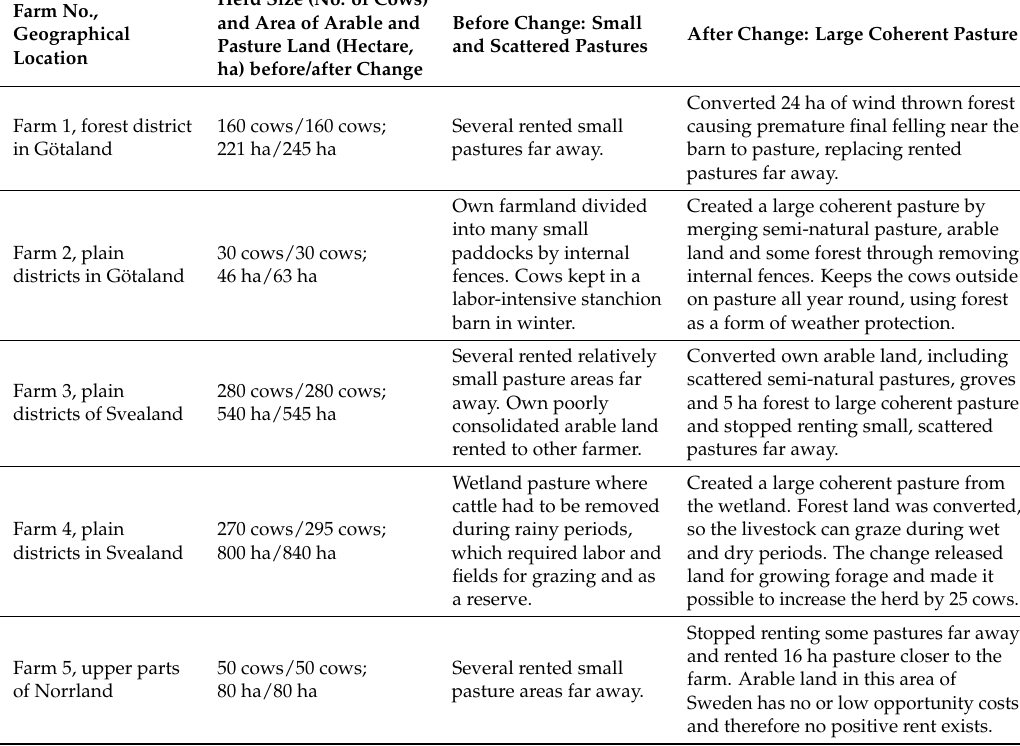
Table 1. Conditions before and after merging small scattered pastures into large coherent pasture-forest mosaics in five Swedish cow-calf